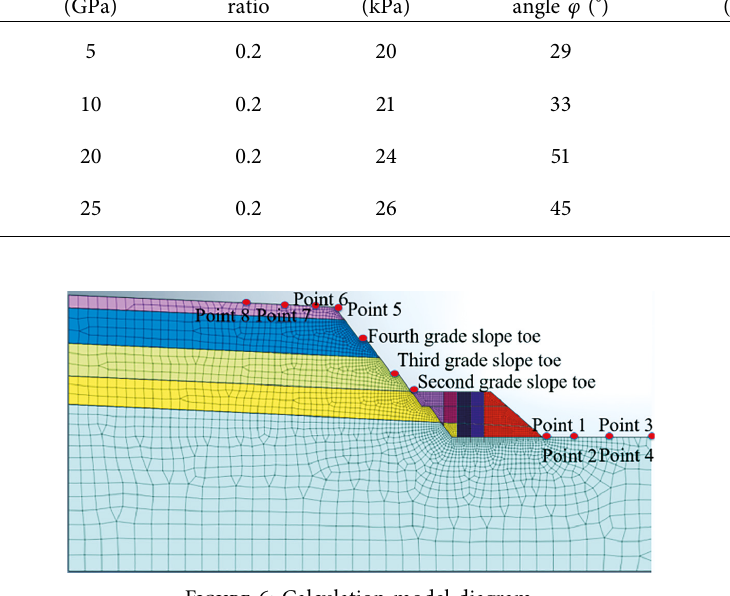
Figure 6: Calculation model diagram.